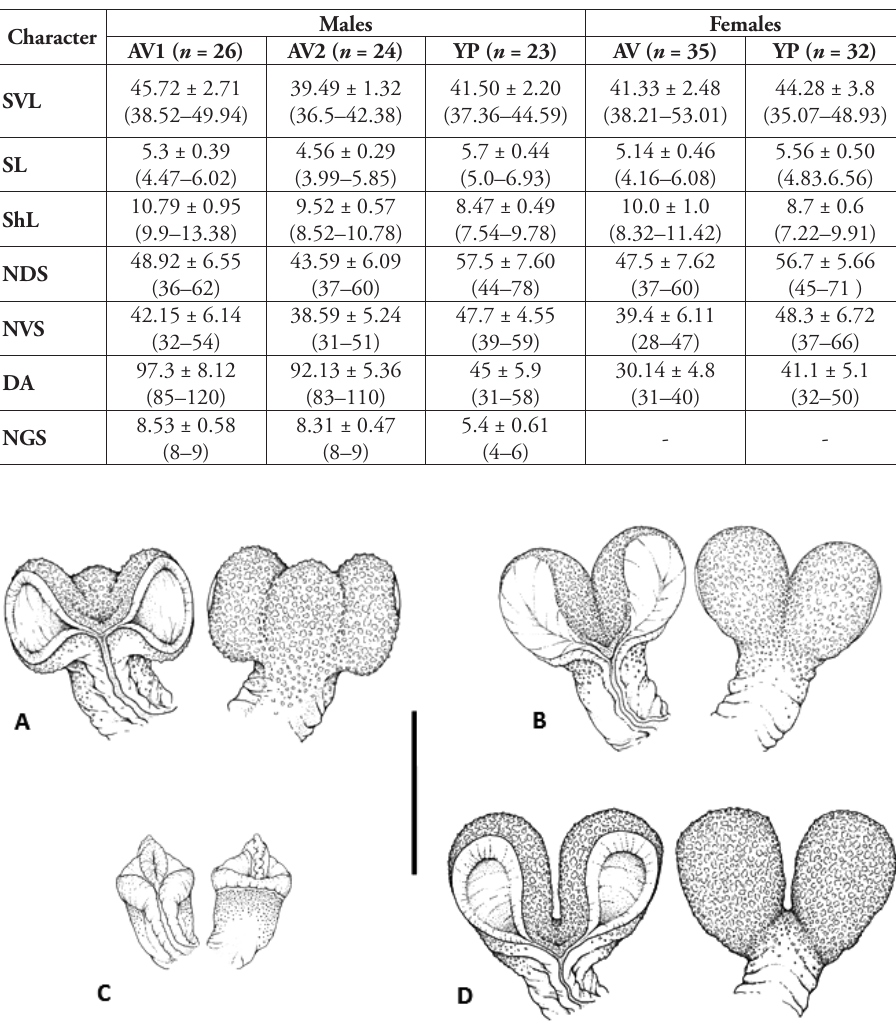
Figure 6. Hemipenial morphologies in sulcate and asulcate views. A North of Sierra de Chiconquiaco, Veracruz (AV; CIB 4945) B South of Sierra de Chiconquiaco, Veracruz (AV;MZFC 227) C Southern Veracruz (AV;CIB 4957) D Yucatan Peninsula (CIB 4982). Scale bar: 0.5 mm.